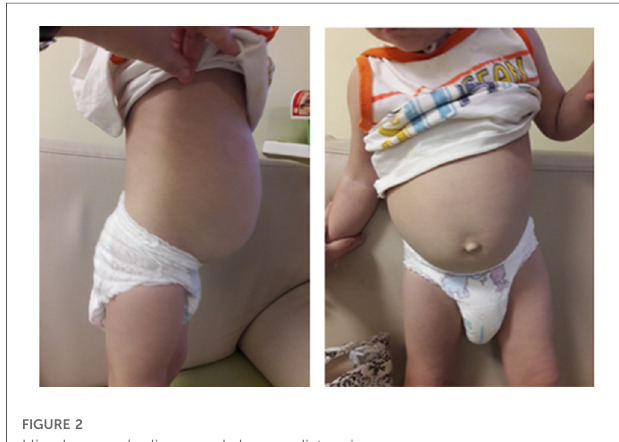
FIGURE 2 Hirschsprung ’ s disease: abdomen distension.